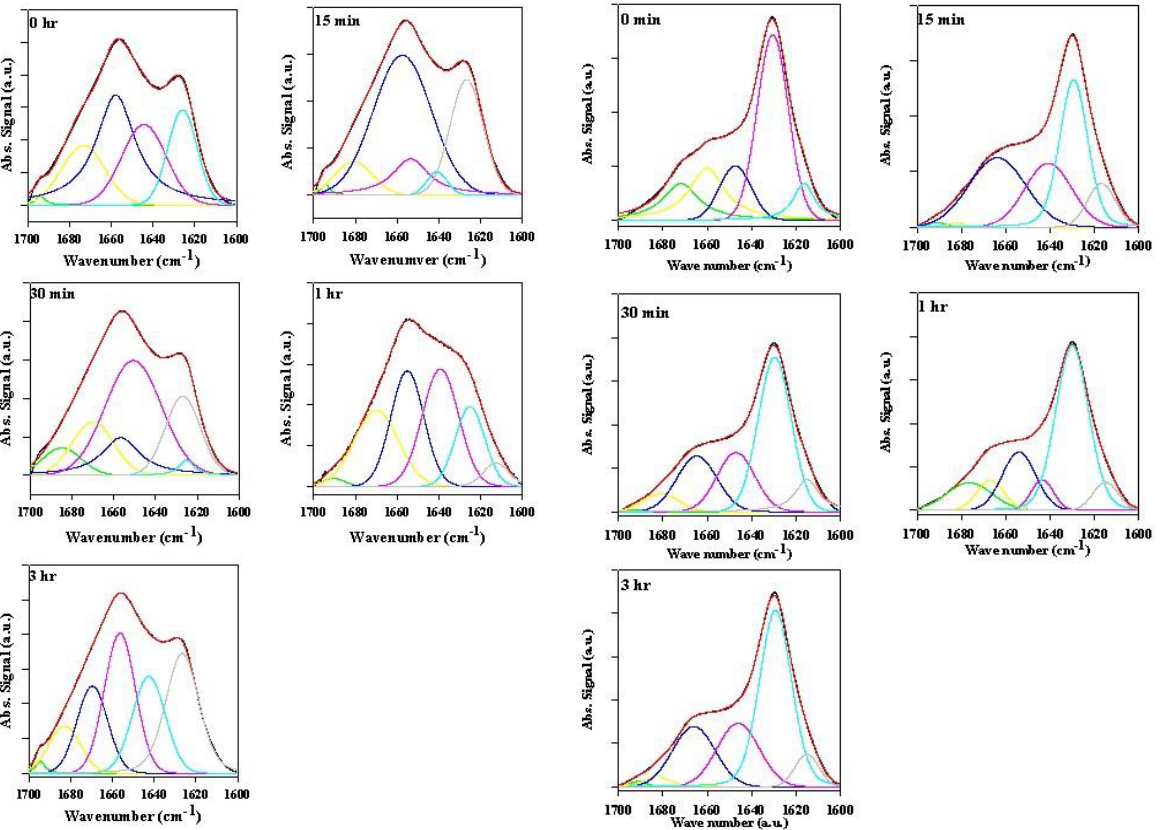
Figure 4. ATR-FTIR spectra of supernatant samples (left panels) and precipitate samples (right panels) taken at the end of the fibrillation process.